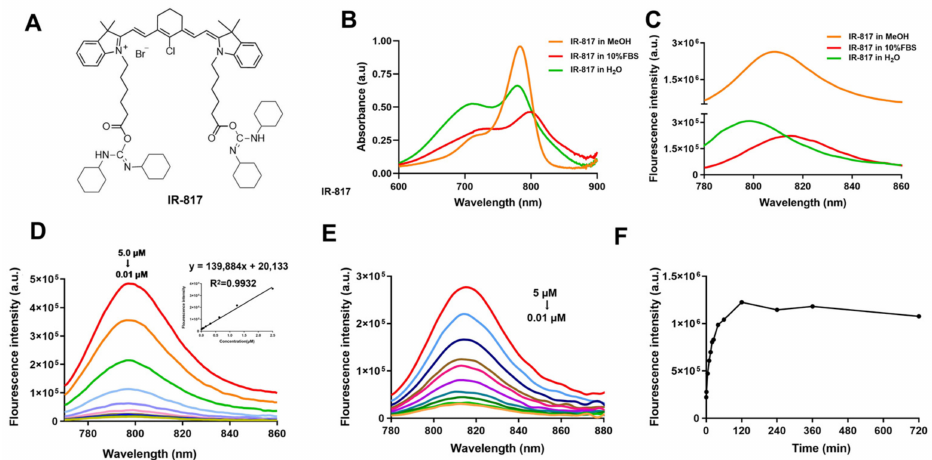
Figure 1. Optical properties of IR-817. ( A ) The structural formula of IR-817. ( B ) Infrared absorption spectra of 5 µ M IR-817 in methanol (MeOH), 10% FBS, and H 2 O. ( C ) Fluorescence emission spectra of IR- 817 in MeOH, 10% FBS, and H 2 O. ( D ) The fluorescence intensity is plotted versus different concentration (0.01–5.0 µ M) of IR-817 in H 2 O and their linear relationship. ( E ) Fluorescence intensity of IR-817 in 10% FBS at different concentrations (0.01–5.0 µ M). ( F ) Fluorescence stability of IR-817 in 10% FBS.